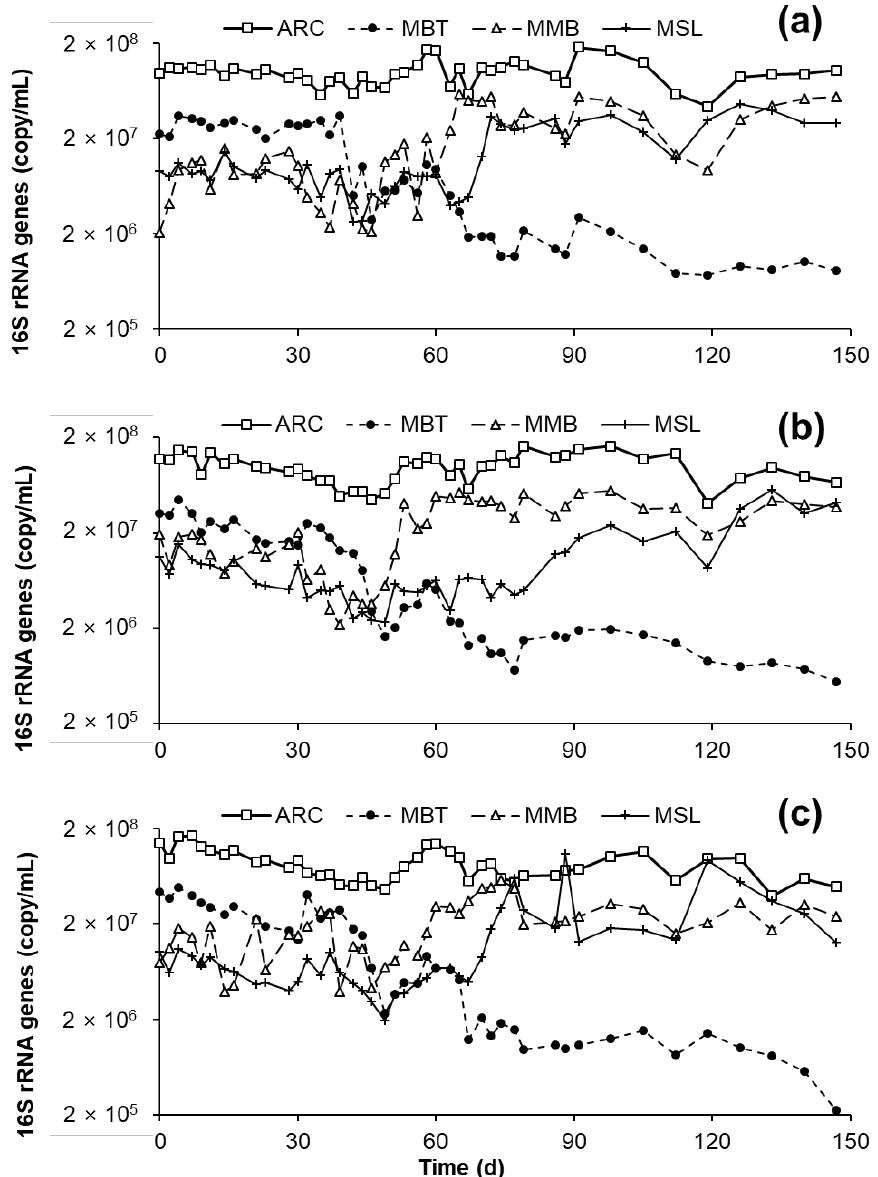
Figure 4. Profiles of 16S rRNA gene concentrations for the full-scale digesters: ( a ) digester A, ( b ) digester B, and ( c ) digester C. Abbreviations: ARC, total archaea; MBT, Methanobacteriales; MMB, Methanomicrobiales; MSL, Methanosarcinales.